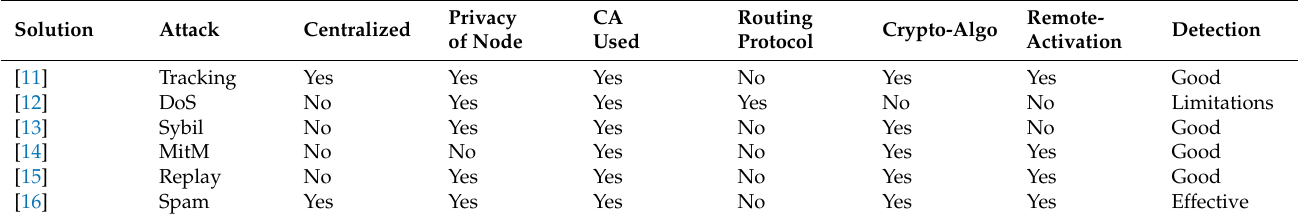
Table 1. Comparison between VANETs location privacy